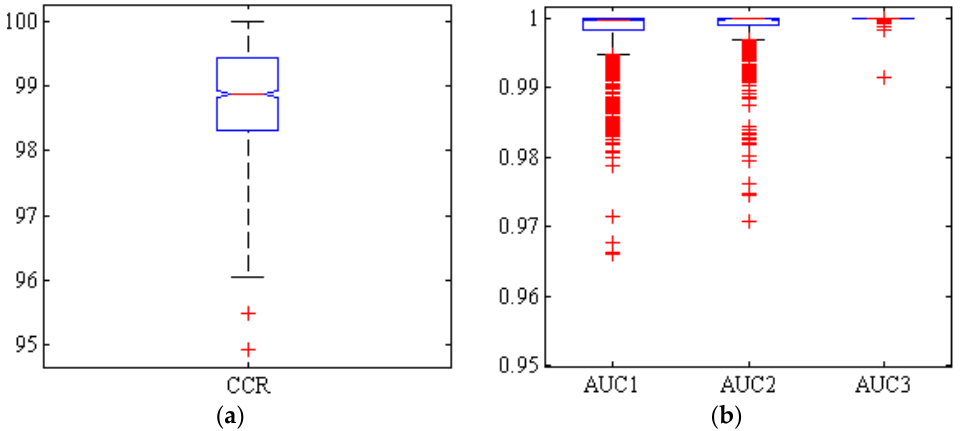
Figure 7. Boxplots of ( a ): the correct classification rate (CCR) and ( b ): area under the ROC curve (AUC) by hybrid ANN-HS classifier, for Adel (AUC1), Arman (AUC2) and Azad (AUC3) chickpea ( Cicer arietinum L.) varieties (1000 uniform random iterations, test set).